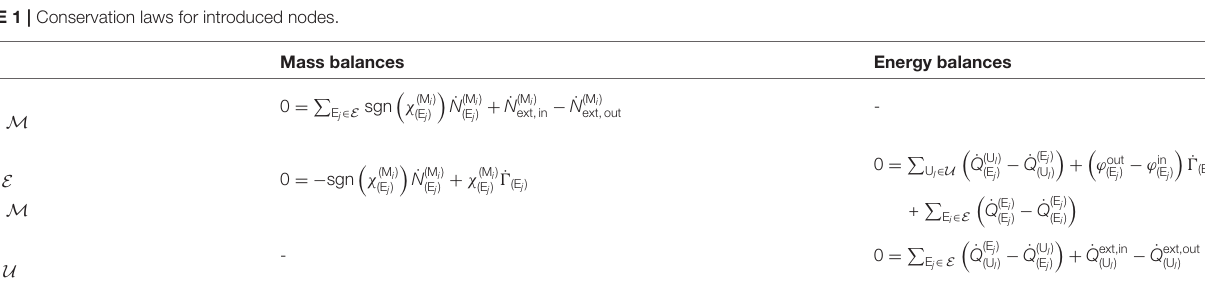
TABLE 1 | Conservation laws for introduced